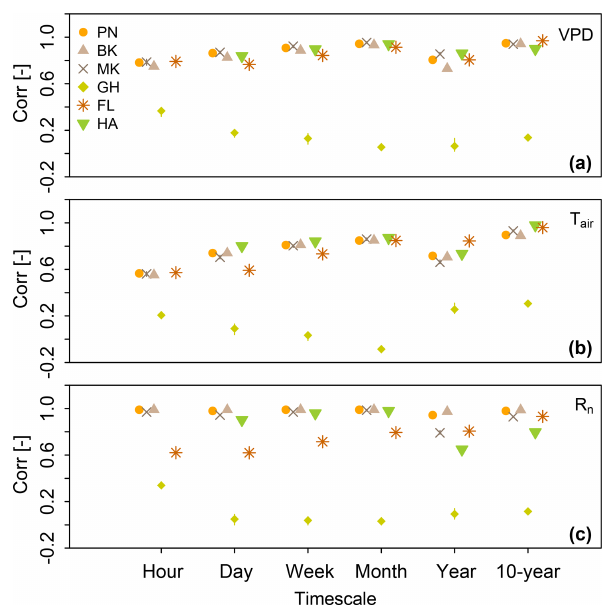
Figure 9. (Dis)agreement between simulated evaporation and mete- orological forcings at different timescales. This correlation is shown for VPD (a) , T air (b) , and R n (c)